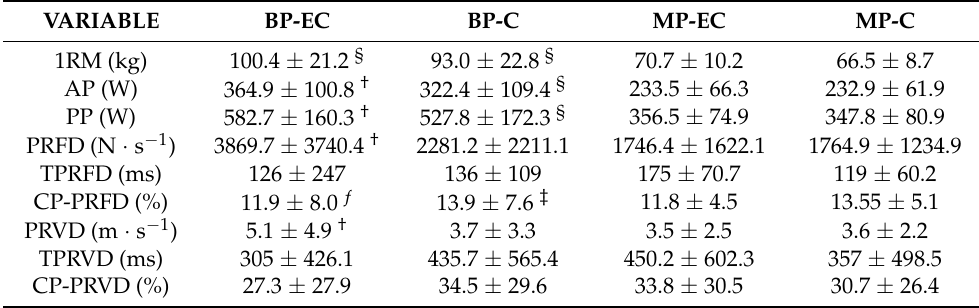
Table 1. Data related to 1RM, power output, rate of force development, and rate of velocity development.